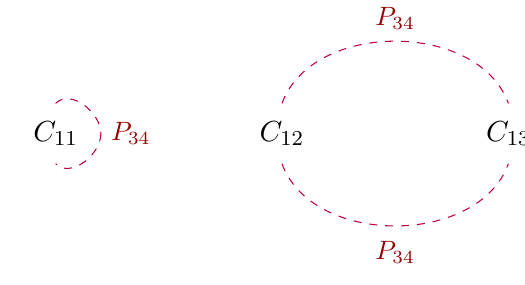
Fig. 3 Orbits of the CWI’s for the T OOO under P